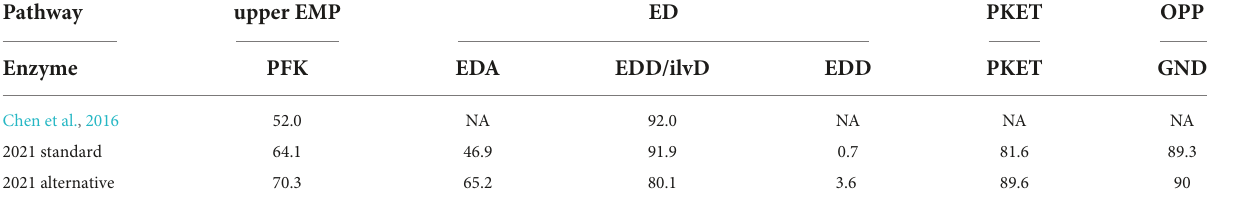
TABLE 1 Occurrence of marker enzymes among cyanobacteria